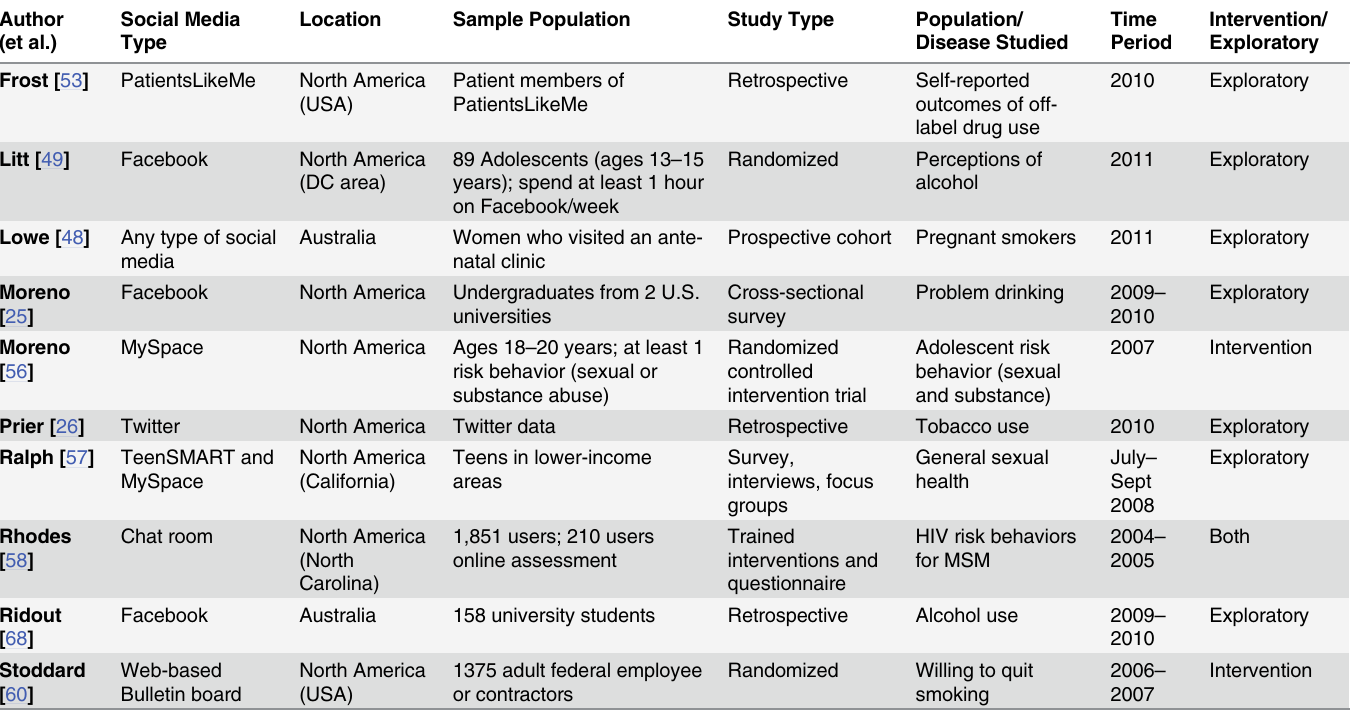
Table 8. Characteristics of 10 health risk behavior studies addressing research question 2 a .